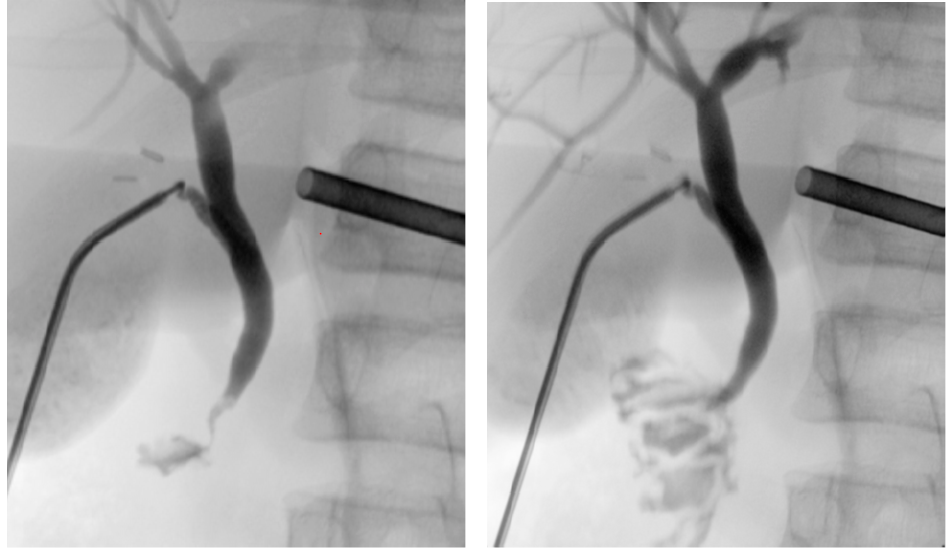
Figure 3. Cholangiography before and after flushing out a small stone in the common bile duct.